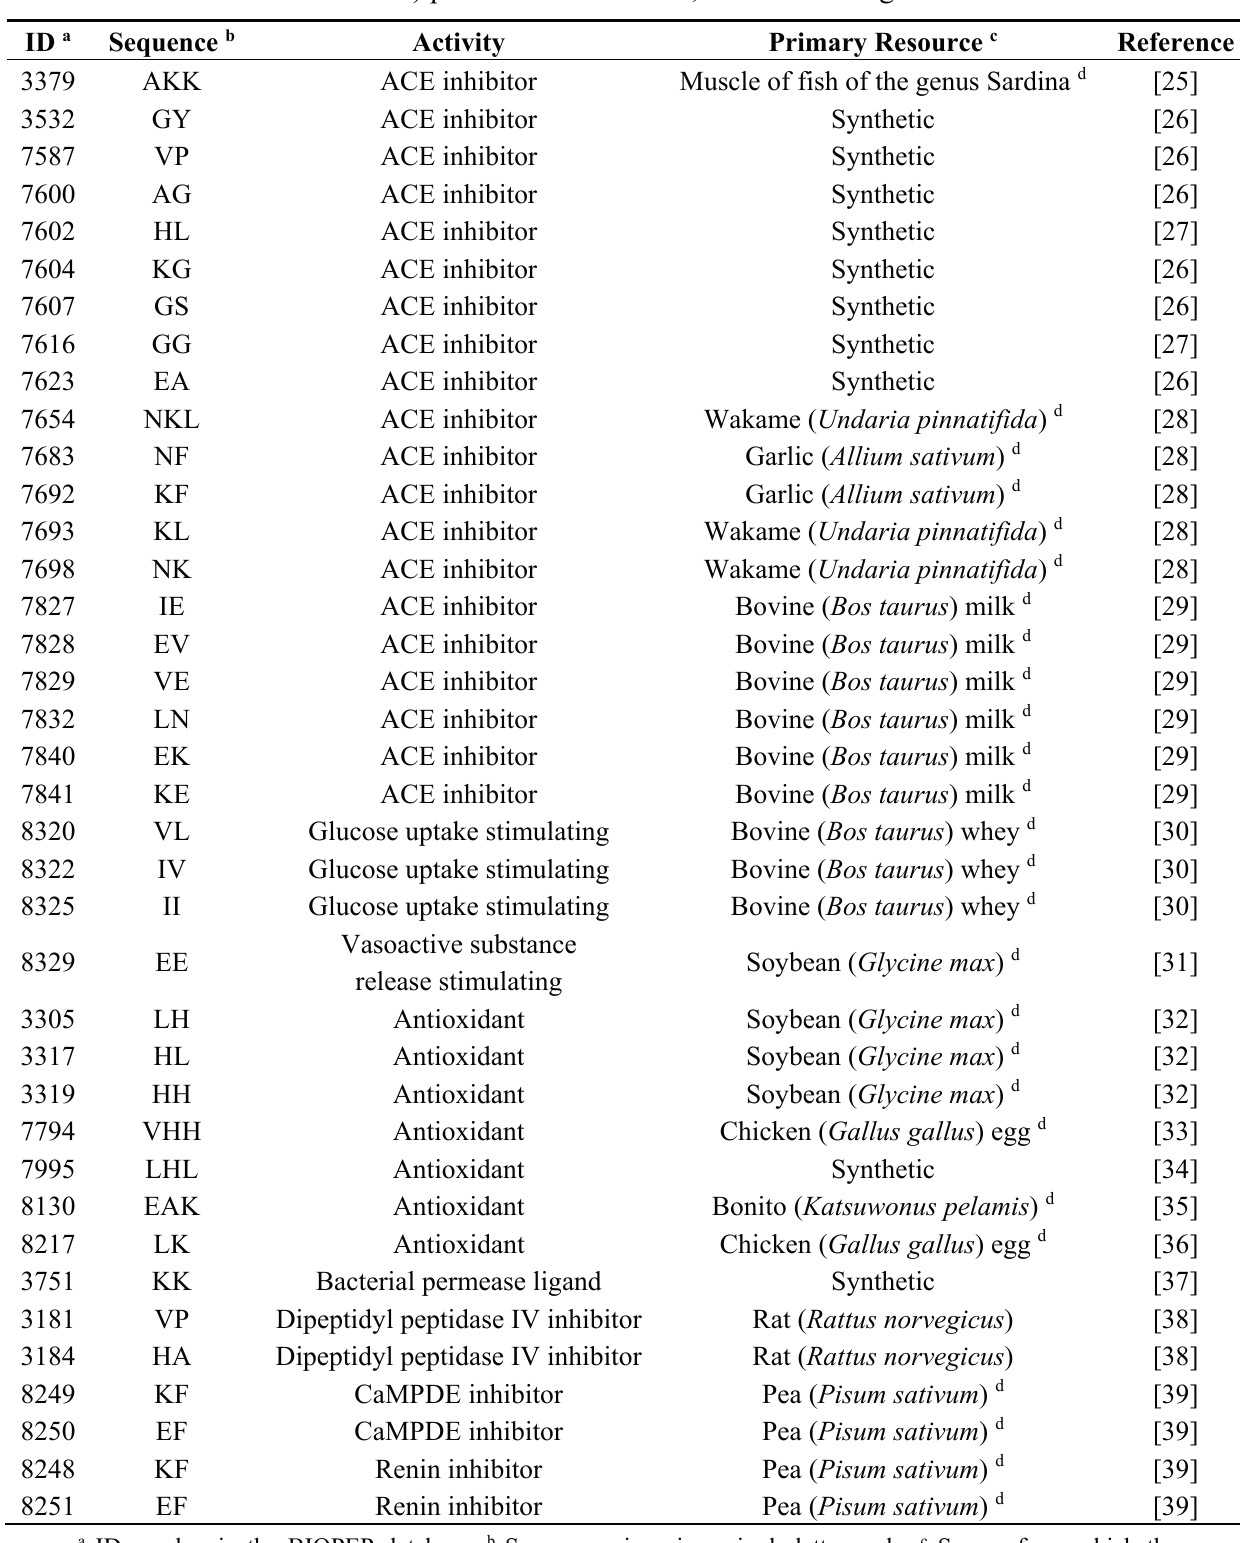
Table 1. Reference data for biologically active fragments of yeast ( Saccharomyces cerevisiae , strain ATCC 204508/S288c) protease B inhibitor 2, indicated in Figure 1. ID